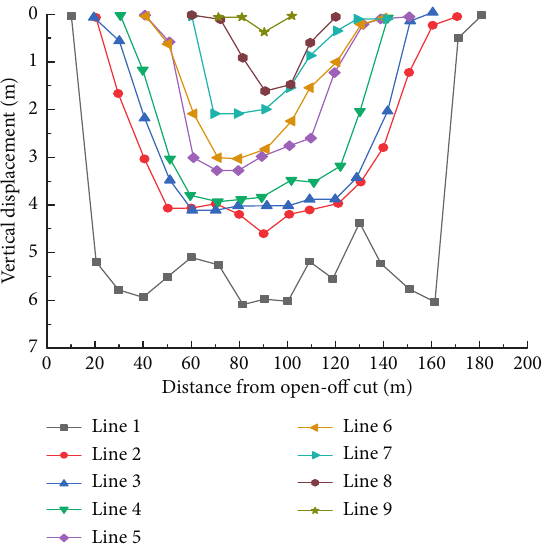
Figure 5: Subsidence after working face is advanced to 160m.